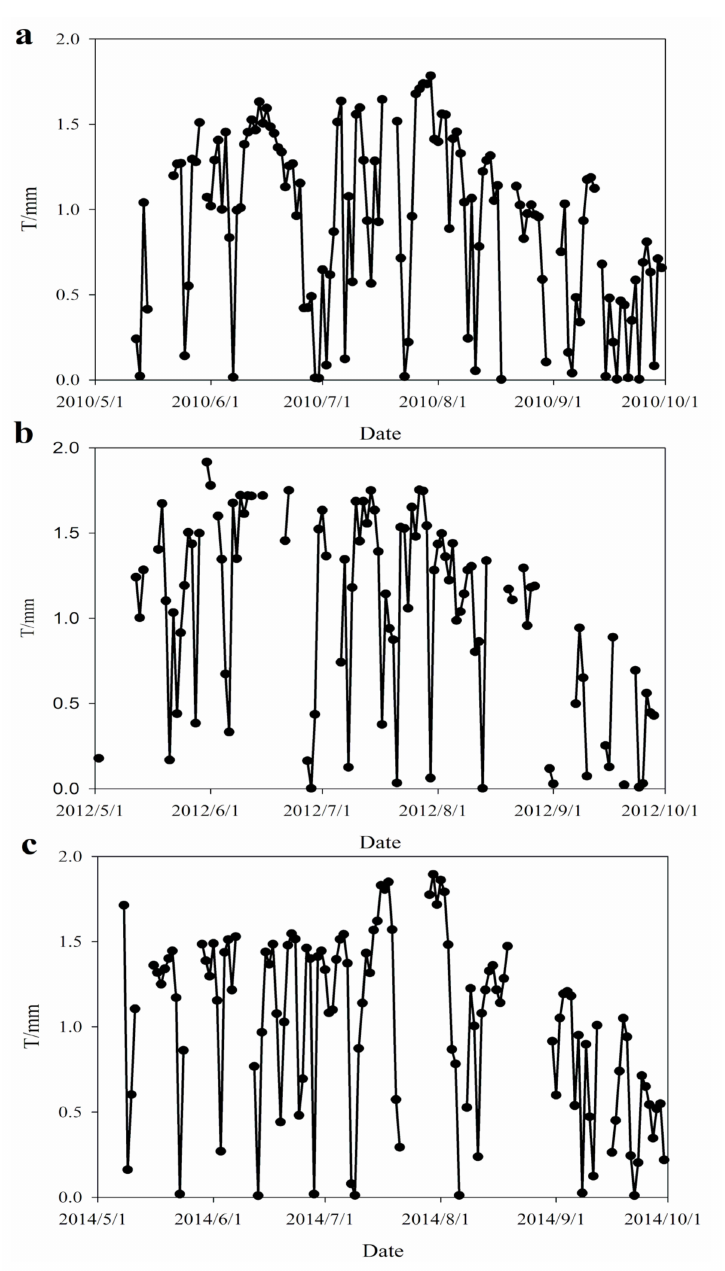
Figure 4. Variations in the daily transpiration (T) in the growing seasons of 2010 ( a ), 2012 ( b ), and 2014 ( c